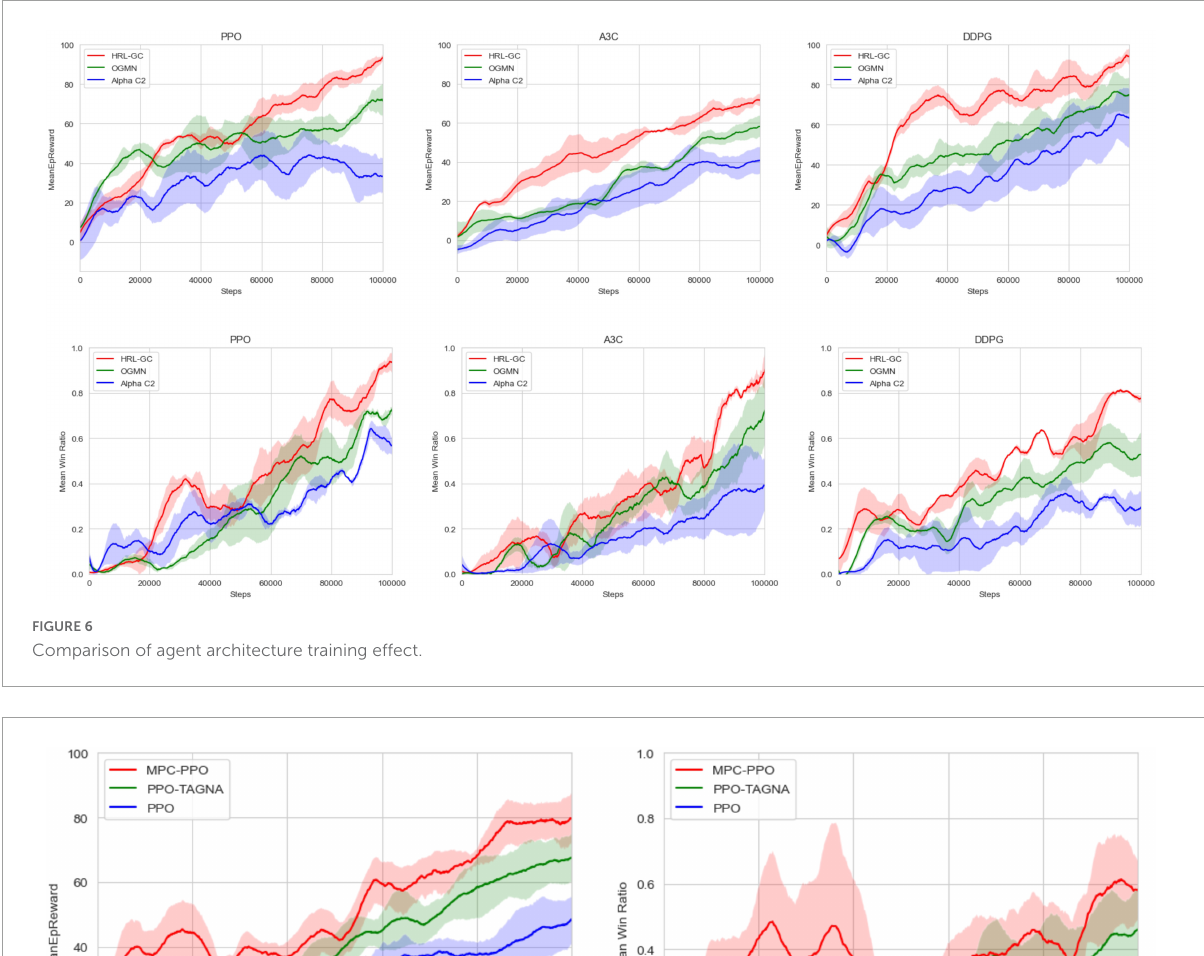
FIGURE7 Algorithm performance